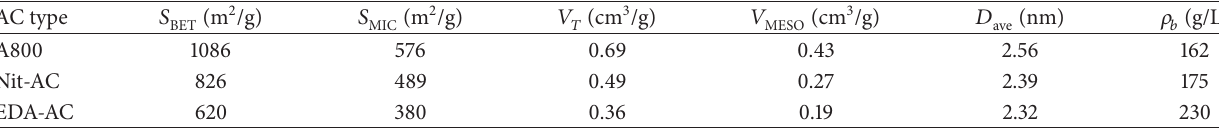
Table 2: Textural properties of activated carbon samples.